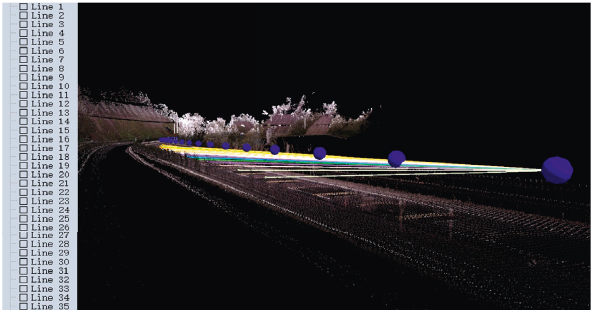
Figure 5: Measurement of 3D ASD in point cloud.